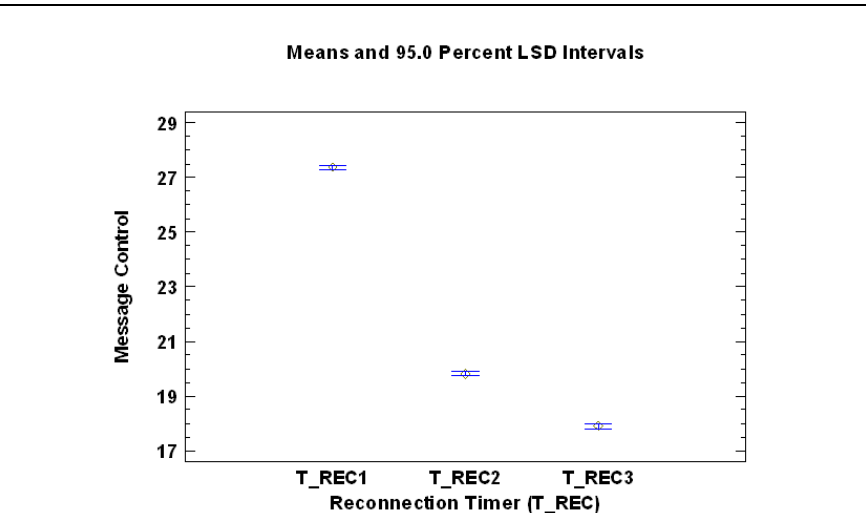
Figure 5. Mean values of the levels of the factor Reconnection Timer, analyzing the dependent variable Number of control messages sent during the set-up time.